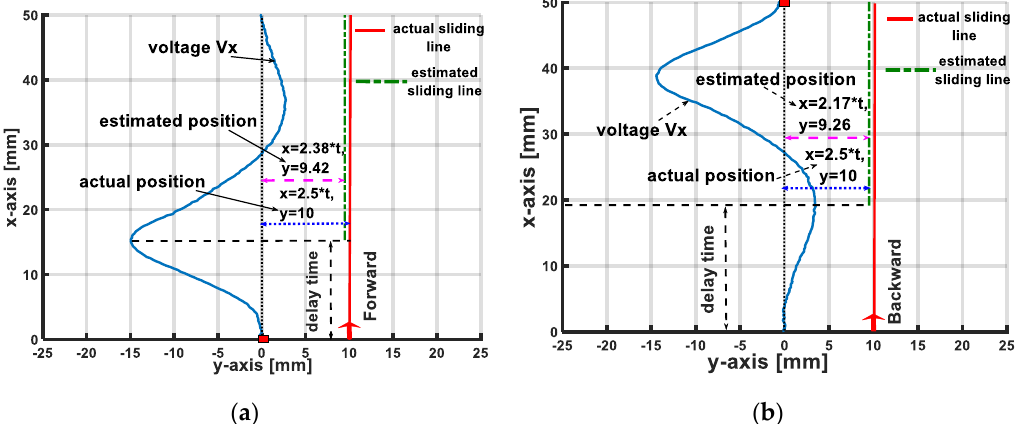
Figure 24. Comparison of actual sliding position and estimated position for X-sliding cases. Actual sliding trajectory is red line, after delay time (when accelerometer’s output voltage reaches extreme values), sensing system can localize sliding object’s positions with errors less than 15% (localized sliding trajectory is blue line). ( a ) X-sliding case: forward direction. ( b ) X-sliding case: backward direction.